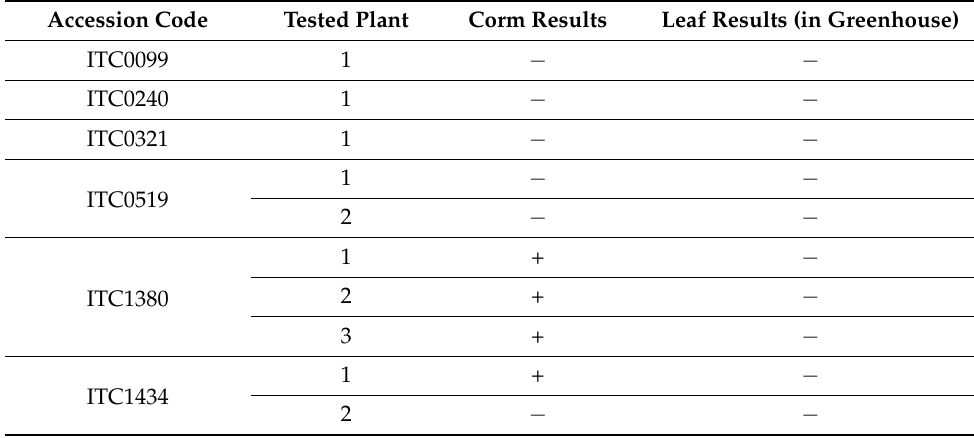
Table 2. Comparison of BanMMV detection between in vitro corm tissues and greenhouse leaf samples of the same 41 banana plants (21 accessions) using IC-RT-PCR. “+” refers to a positive result; “ − “ refers to a negative result; the healthy accessions used as negative controls through this experiment were ITC0245, ITC0654, and ITC1120, and they tested